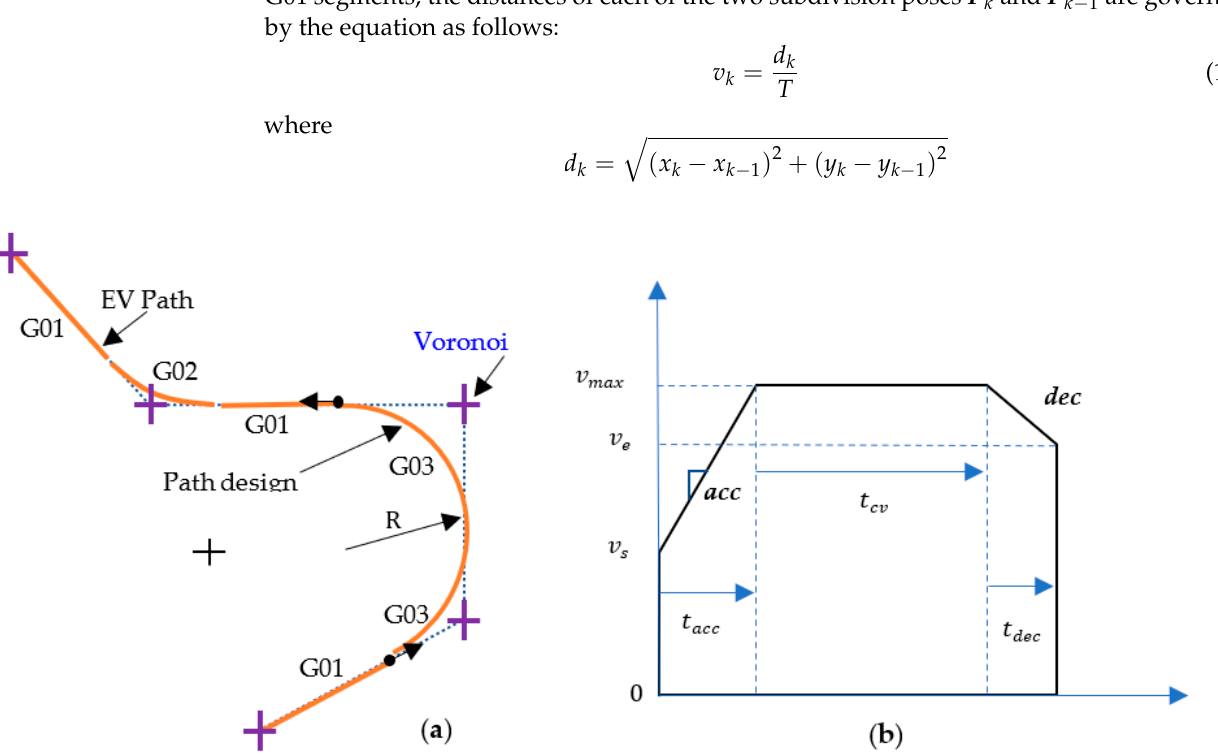
Figure 6. ( a ) Conversion of Voronoi path to motion path; ( b ) acceleration and deceleration for linear interpolation.